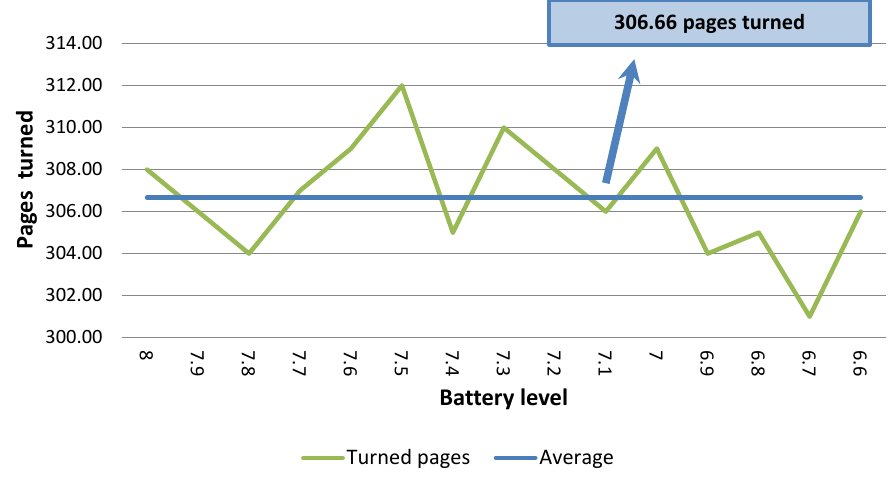
Figure 6. With the thick wheel model and non glossy 80 gr/m 2 pages.